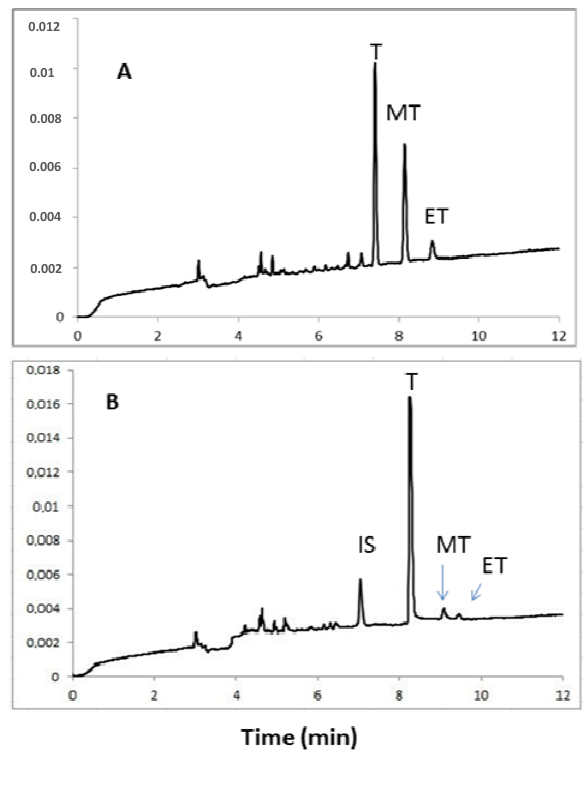
Figure 4. Electropherograms obtained during the electrophoretic separation of urine samples from amateurs weight-lifters, using hormonal doping. Conditions as in Figure 1. Analytes: T—testosterone, MT—17 α -methyltestosterone, ET—epitestosterone,